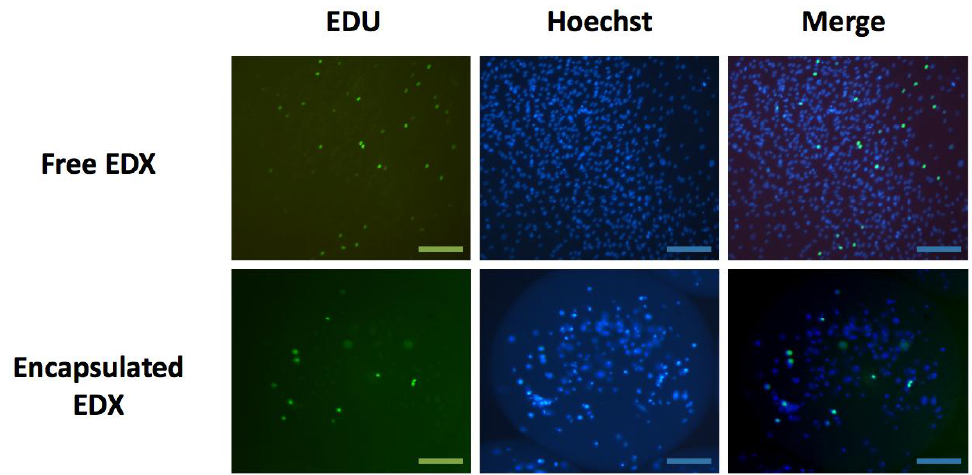
Figure 6. Proliferation of EDX cells 24 h after microencapsulation in alg-PEG-M. From left to right: green (EdU) shows proliferating cells; blue (Hoechst) shows all cells; Merge shows the overlay of EDU and Hoechst. Scale bars: 100